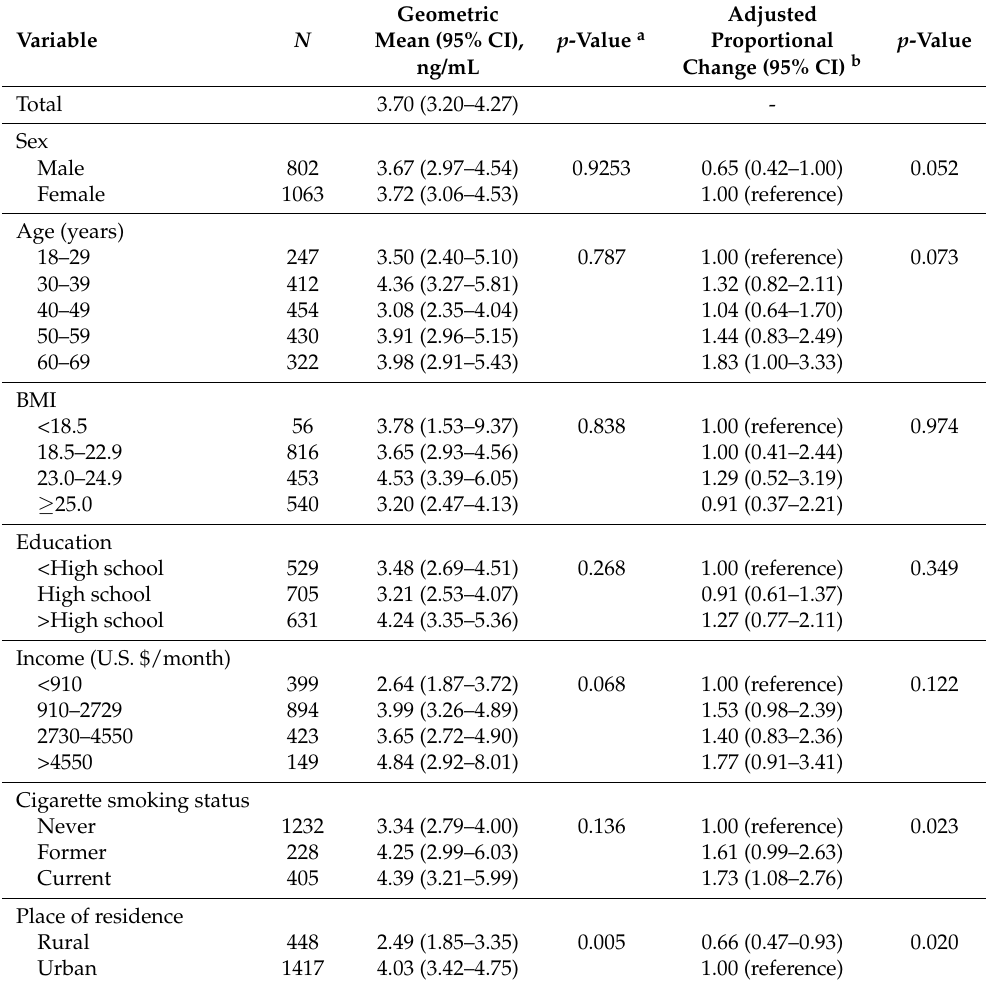
Table 4. Population-weighted geometric means and adjusted proportional changes in urinary 4-nonylphenol concentrations by demographic characteristics in the Korean population aged 18–69